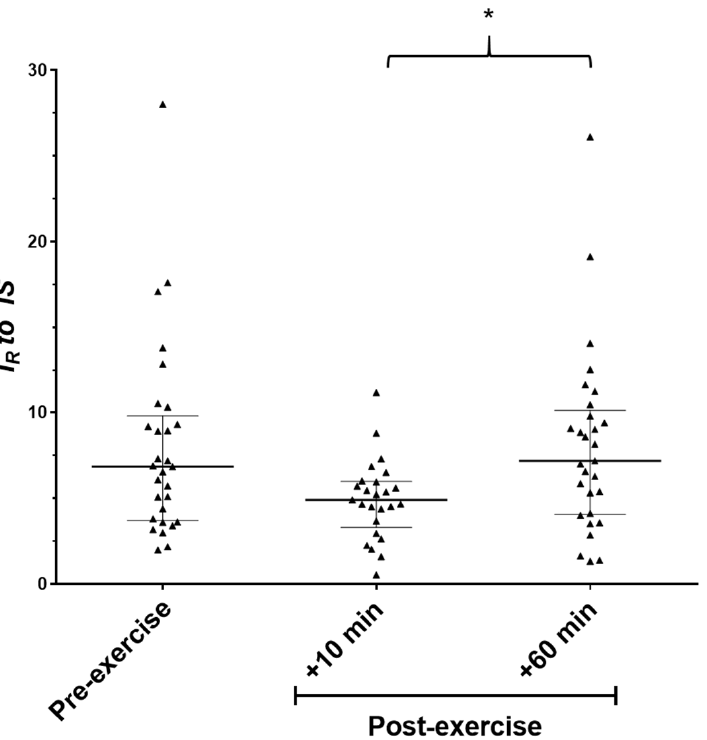
Figure 2. Box and whisker plots to display exhaled isoprene levels for all participants ( n = 33) at pre- and post-exercise timepoints. * Denotes p = 0.041. Note: I R = relative intensity; IS = internal standard.